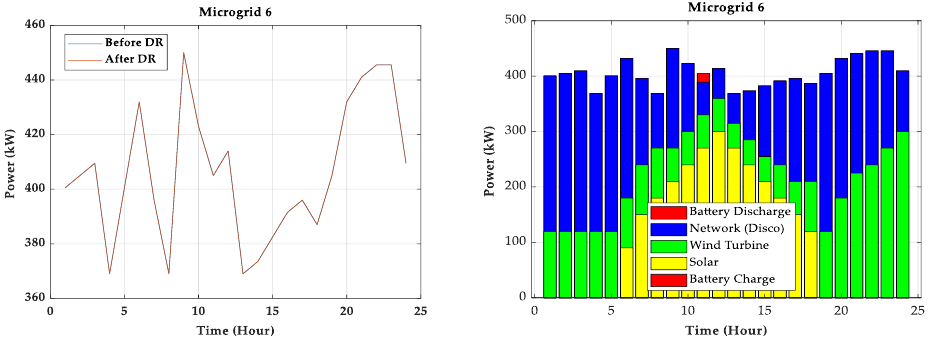
Figure 20. Load curve of MG 6.